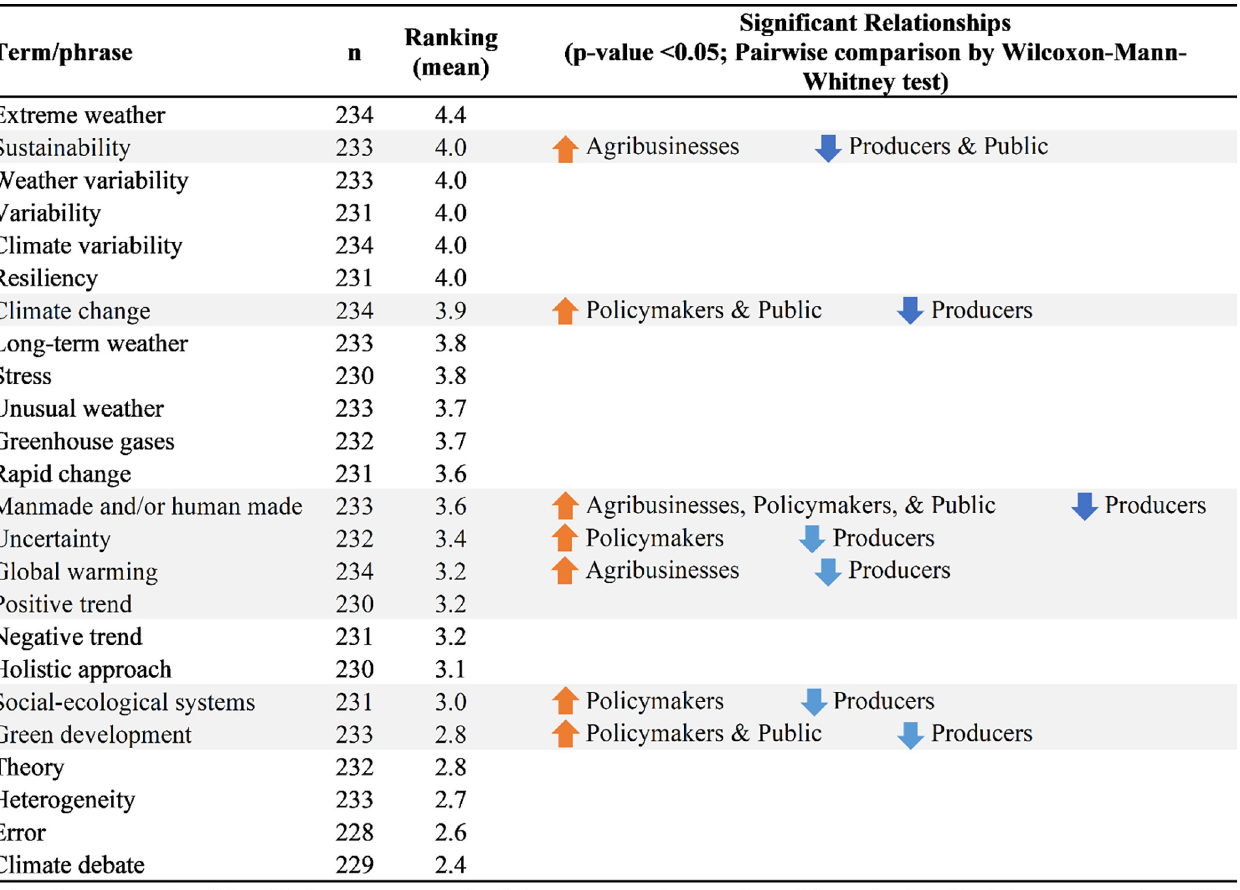
Fig 2. Scientists’ likelihood of using terminology sorted by overall decreasing likelihood ranking. Notes. Survey question: “How likely are you to use the following terms/phrases when talking to [stakeholder] about climate change?”. scale: 1 = extremely unlikely, 2 = unlikely, 3 = neither likely nor unlikely, 4 = likely, 5 = extremely likely Arrows indicate likelihood of use relative to the other stakeholder group. See S5 Table for mean and median by stakeholder group, and detailed statistical model results. The rows with arrows indicate the statistically significant relationship (p-value < 0.05) from pairwise comparison determined by Wilcoxon-Mann-Whitney test adjusted by Bonferroni correction